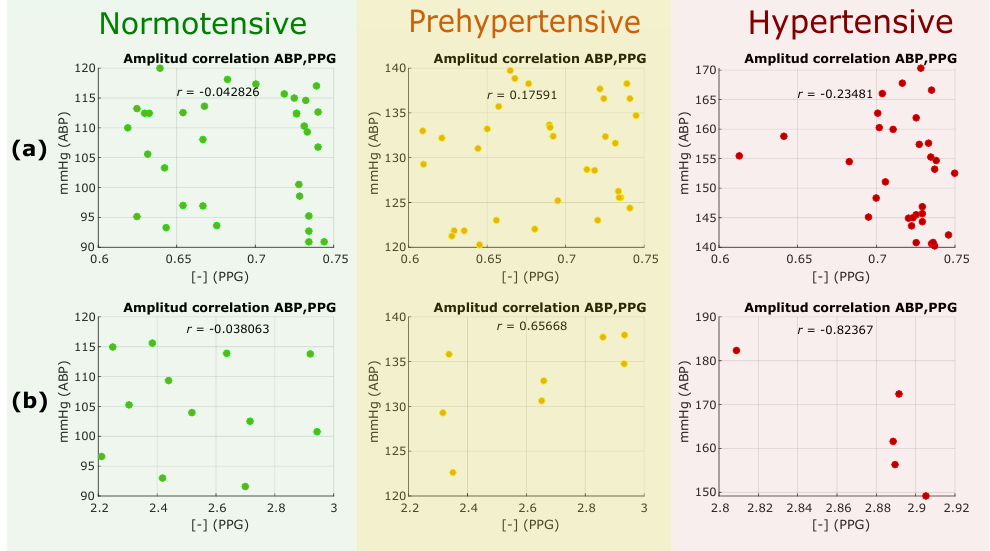
Figure 2. Results of in-phase analysis: ( a ) Analysis results for the group with an amplitude range of 0.6–0.75 of the PPG signal; and ( b ) analysis results for the group with an amplitude range of 2.2–3 of the PPG signal. The groups are derived from the different gains of the equipment with which the signals were registered. r refers to the morphology correlation between photoplethysogram (PPG) and arterial blood pressure (ABP) waveforms.